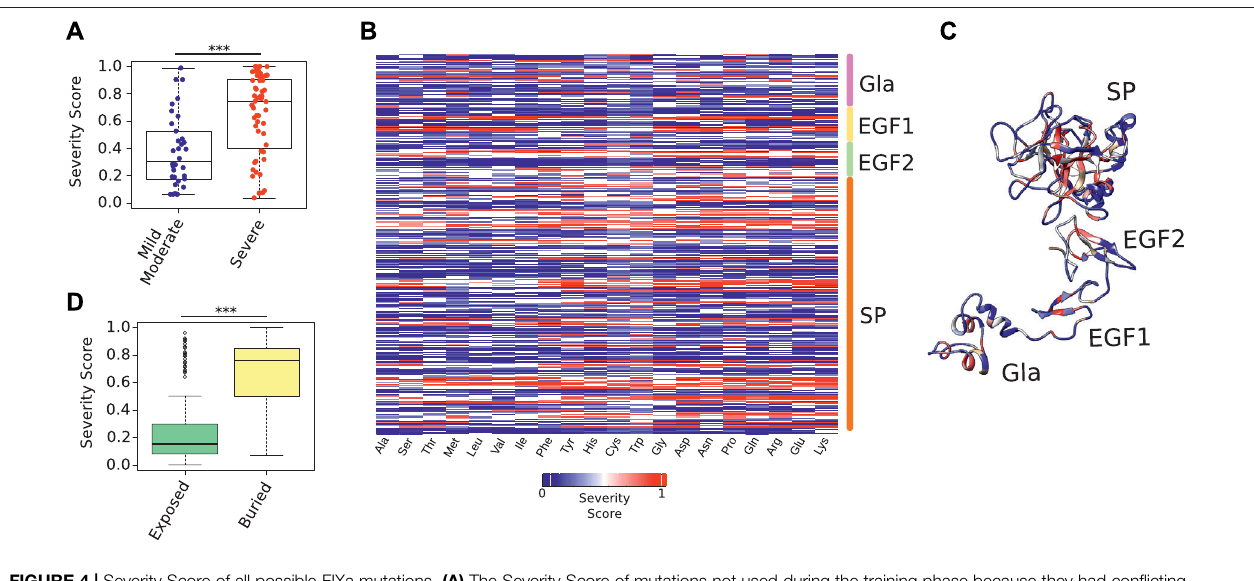
FIGURE 4 | Severity Score of all possible FIXa mutations. (A) The Severity Score of mutations not used during the training phase because they had con fl icting symptoms reported in the medical literature. Our predictions agreed with the majority class of each mutation ( Supplementary Table S5 ). (B) The Severity Score predictedbytheHemB-ClassframeworkforthemutationsofeachFIXaresiduetothe19remainingaminoacids. (C) ThelocationoftheresidueswiththehighestSeverity Scores. These residues, located at the core of each FIXa domain, are unlikely to accept any amino substitution ( Supplementary Table S6 ). (D) The most buried residues(lessthan25%relativesurfaceexposure),havesigni fi cantlyhigherSeverityScoresthanthemostexposedresidues.Theboxplotsshowthemedian(centerline), the fi rst and third quartiles (lower- and upper-bounds), and 1.5 times the inter-quartile range (lower- and upper whiskers). Each dot in the plot is an amino acid mutation (i.e., a clinical case report). Unpaired, two-sided Wilcoxon test (*** p -values < 0.001; ** p -value < 0.01; * p -value <